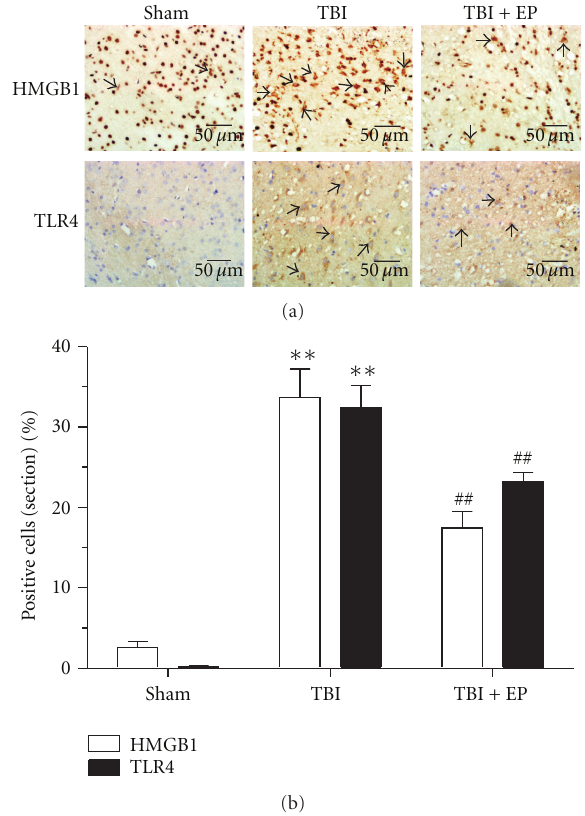
Figure 8: Immunohistochemistry staining showed the expression of HMGB1 and TLR4 protein in the brain tissue. The cytoplasm or extranuclear HMGB1 staining cells were considered as HMGB1- positive cells. (a) Immunohistochemistry staining showed that HMGB1 distributed mostly in the cell nucleus within the Sham group. Few HMGB1 and TLR4 positive cells were observed in the representative cortex. However, in the TBI group, TBI induced HMGB1 redistribution and TLR4 expression. HMGB1 cytoplasm translocation was observed in brain cells. However, EP treatment to the rats significantly decreased HMGB1 translocation and TLR4 expression. Arrows indicated representatively HMGB1 and TLR4 positive cells in the surrounding region of contusion cortex. Scale bars: 50 μ m. (b) Quantification of HMGB1 and TLR4 positive cells in each group. TBI induced a marked increase of HMGB1 and TLR4 positive cells in the brain tissue surrounding the contusion cortex compared to the Sham group ( P < . 01). And EP treatment significantly reduced HMGB1 and TLR4 positive cells in TBI + EP group than that compared to the TBI group ( P < . 01). Bars represent as mean ± SEM; n = 6, each group; ∗∗ P < . 01 versus Sham group, ## P < . 01 versus TBI